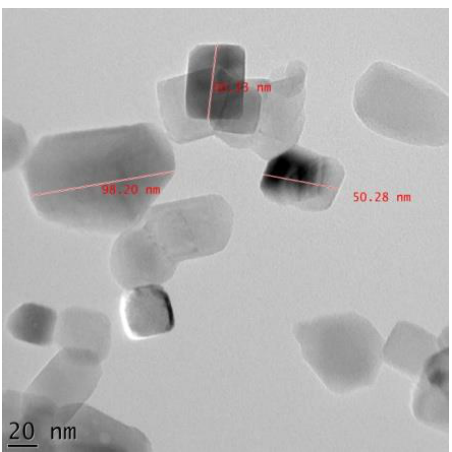
Figure 3. HR-TEM image of as-prepared Mg-HA.